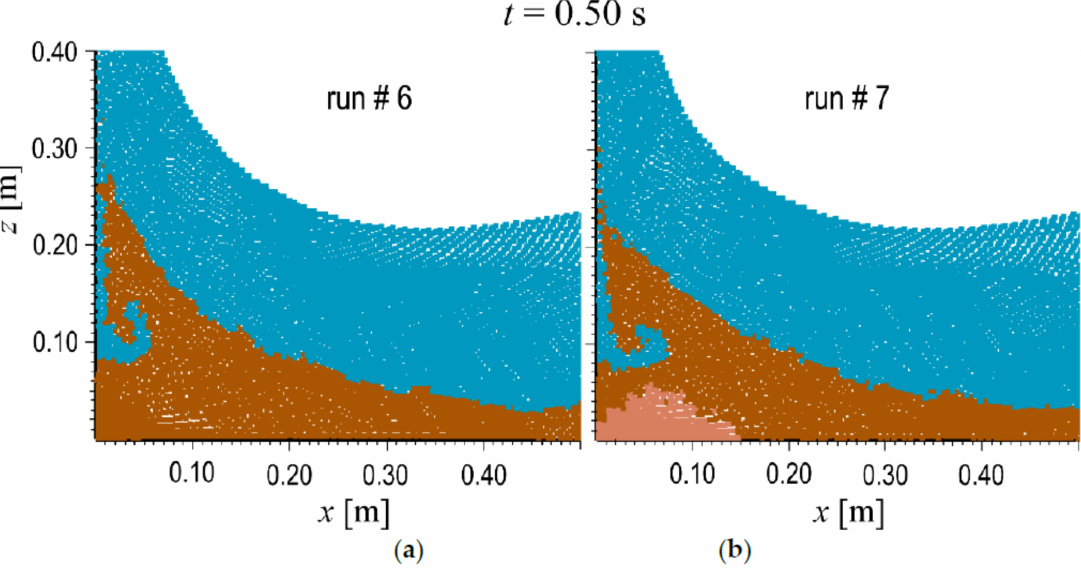
Figure 5. Magnification of the maximum sediment run-up: ( a ) Run 6; and ( b ) Run 7. Light brown solid particles in the right-hand panel are in the elastic–plastic regime